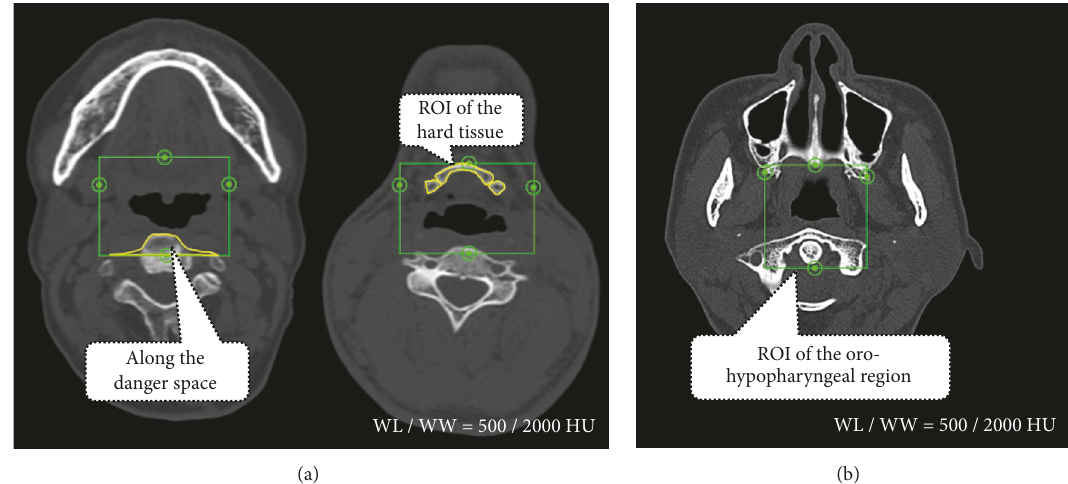
Figure 7: The region of interest (ROI) used for calculating the hard tissue and oro-hypopharyngeal region volumes. The ROI of the hard tissue and oro-hypopharyngeal region were set by manually tracing all the axial cross-sectional images of the oro-hypopharyngeal region. To set the ROI, a danger space was used in the area of the cervical vertebrae to maintain bone morphology continuity. All the hard tissue and oro-hypopharyngeal region ROIs in the oro-hypopharyngeal region assessed using multislice computed tomography data at baseline and data with the mandibular advancement appliance (MAA) were superimposed. Abbreviations: WL/WW, window level/window width.